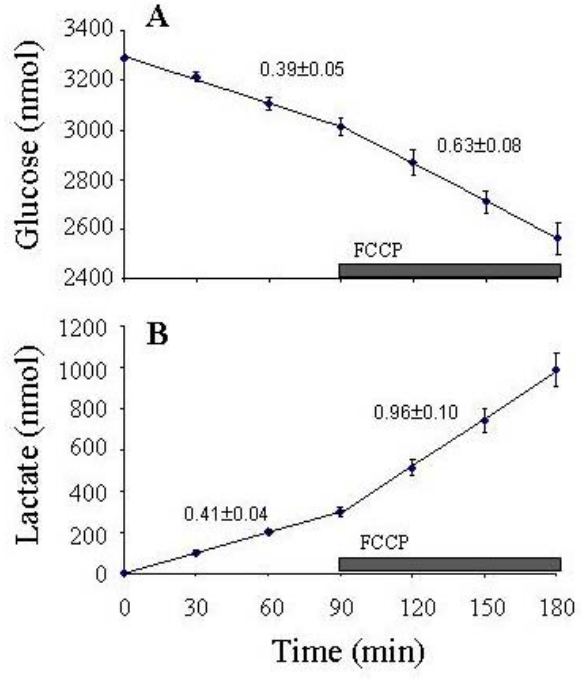
Figure 5. Glucose utilization ( A ) and lactate production ( B ) by CGNs in 2-well chambers. Neurons were incubated with 350 μ l high K + /serum as detailed in Figure 4. Where indicated, 1 μ M FCCP was included to increase H + leak flux. This modulation was propagated through the system via the intermediates to affect glucose uptake and lactate production. Data are the mean ± S.E.M. of three independent experiments. Rates are expressed in nmol/min x 10 6 cells, as determined from the least-squares regression slopes.